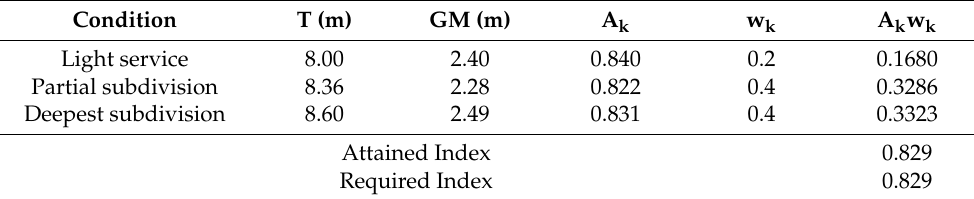
Table 8. Attained index calculations for cruise ship C1 with AREST P1 reconfiguration.